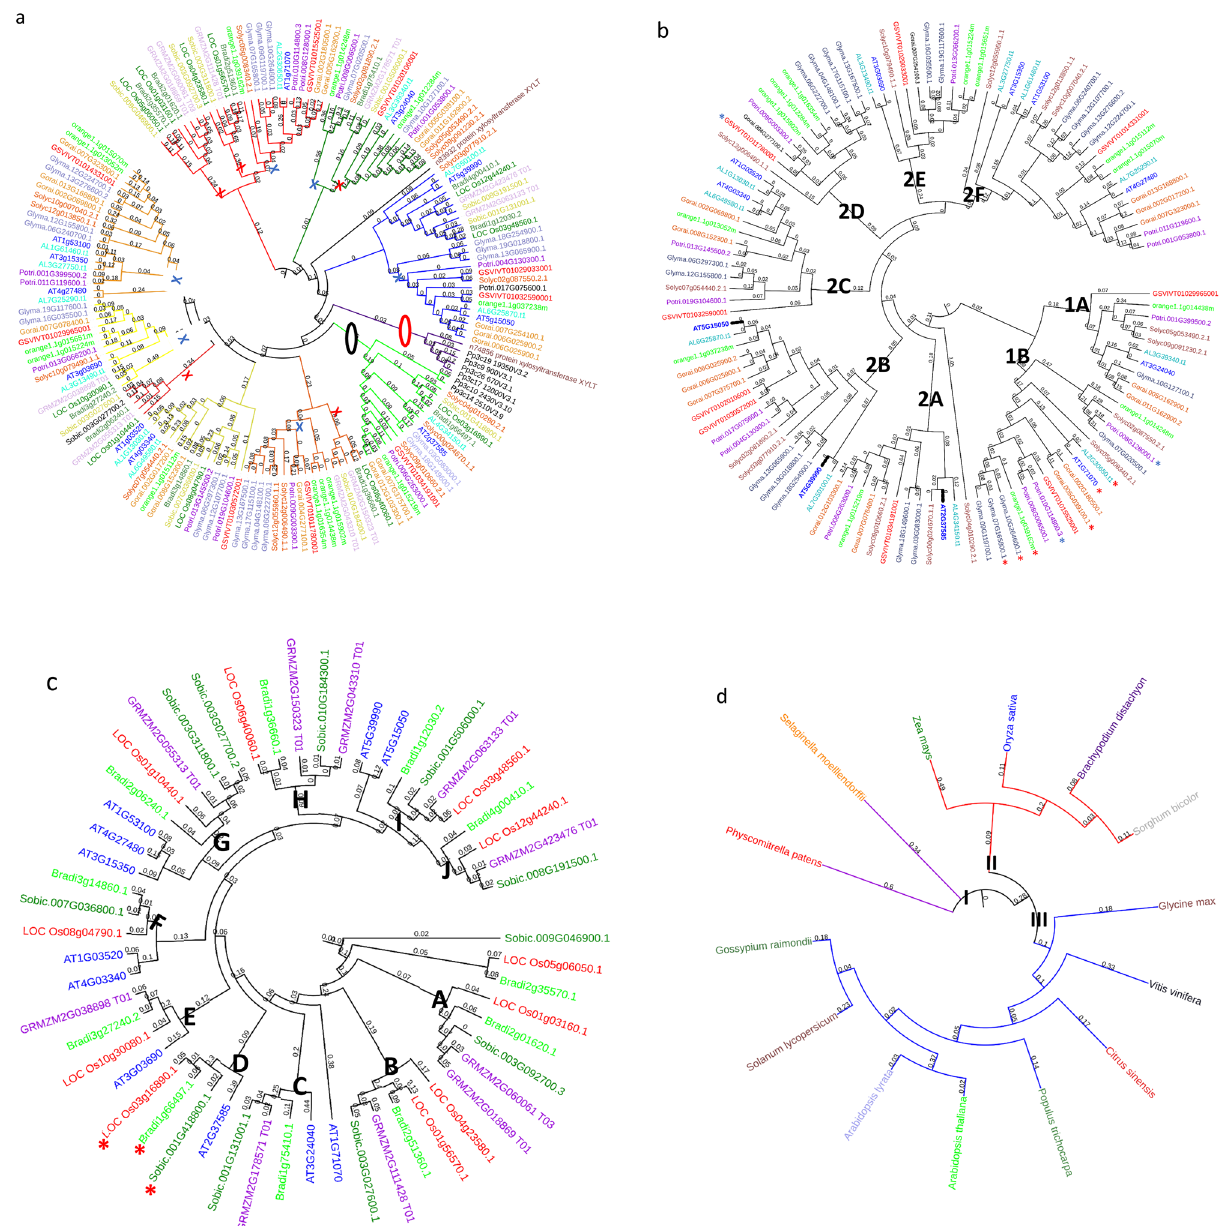
Figure 2. Phylogenetic analyses of putative GLCATs in plant genomes using maximum likelihood method. Figure showed the phylogenetic analyses in 14 plant species investigated ( a ), dicots ( b ), monocot grasses ( c ) and AtGLCAT14A orthologs in 14 plant species ( d ). In ( a ), the phylogenetic tree was created with the full-length GLCAT protein sequences from 14 plant species based on the maximum likelihood method. Ten phylogenetic classes (classes a – j ) were identified. The blue X and red X represent dicot and monocot grass specific clades respectively, corresponding to the different species. The red oval indicates a phylogenetic clade specific to lower land plants while the black oval indicates a clade shared by lower (bryophytes) and higher land plants (monocot grass and dicots). In ( b ), eight phylogenetic clades (classes 1a , 1b and 2a – f ) were identified. The red and blue asterisks indicated amino acid changes in the second D residue from D → N and D → T in the DWD consensus motif found in plants respectively. In ( c ), ten phylogenetic clades (clade a – j ) were identified and clades were assigned if it contained minimum of 3 out of the 4 monocot grasses investigated. The red asterisks indicated amino acid changes D → S in the X/DWD/X motif respectively. Arabidopsis GLCAT sequences were included for efficient classification. Genes with no asterisk possess no substitution. In ( d ), the phylogenetic tree was created with the full-length protein sequences of AtGLCAT14A (AT5G39990) and its orthologs in the 14 plant species by the Bayesian Inference using the Bayesian Markov Chain Monte Carlo method as implemented in BEAST software v1.5.4 34 . Support values/posterior probabilities and branch lengths are indicated while I, II and III corresponds to labels for foreground and background in branch and branch-site